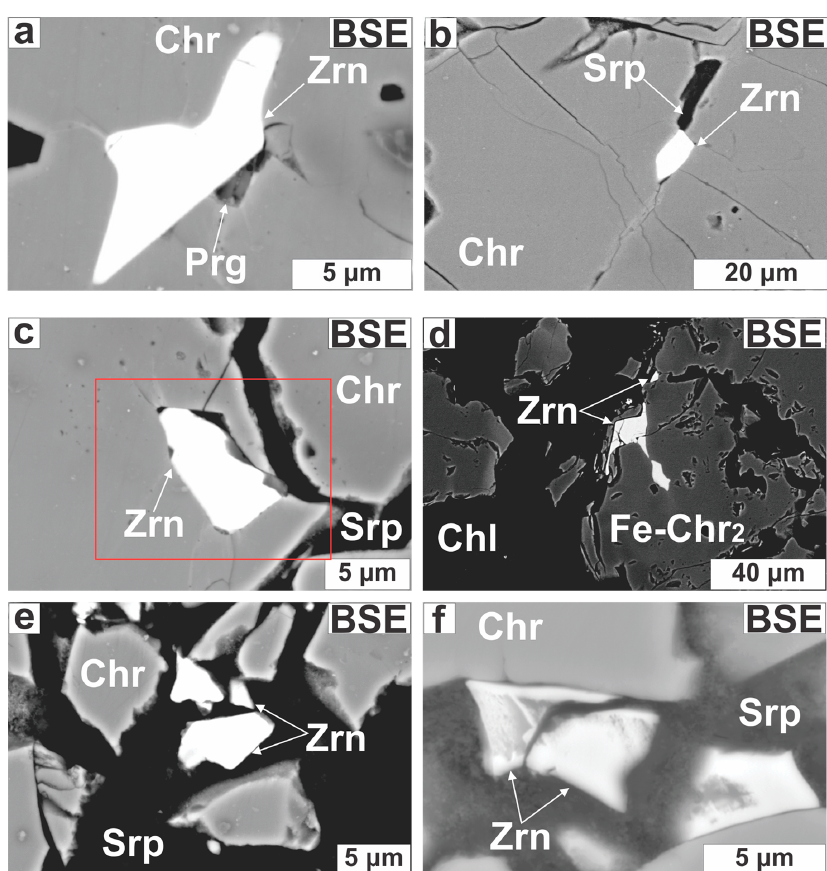
Figure 6. Photomicrographs showing the micro-structural sites of zircons. ( a – c ) Zircon found along open or healed cracks in Cr-spinel; ( d ) Zircon hosted by porous spinel; ( e , f ) Zircon in cataclastic zones. Abbreviations: Zrn = zircon; the rest as in Figures 4 and 5.